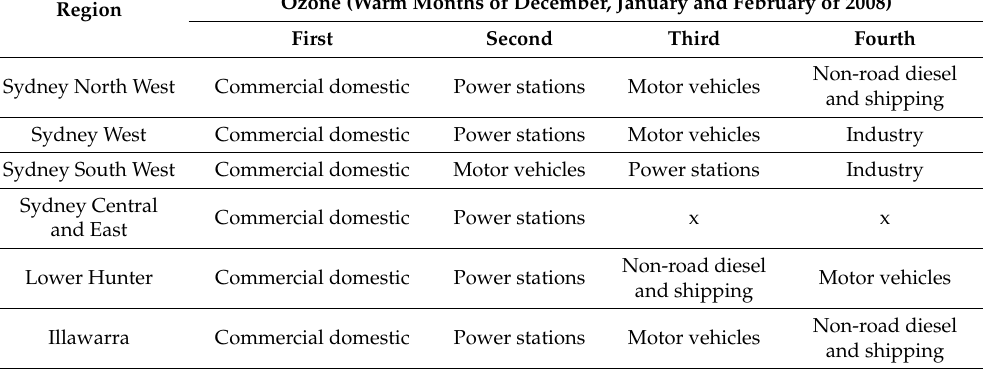
Table 5. Ranked order of contribution from anthropogenic sources to maximum 1-h ozone (warm months). For Central and East Sydney, motor vehicle or industry emission decreases the maximum 1-h ozone (negative contribution) and is denoted by x in the table.